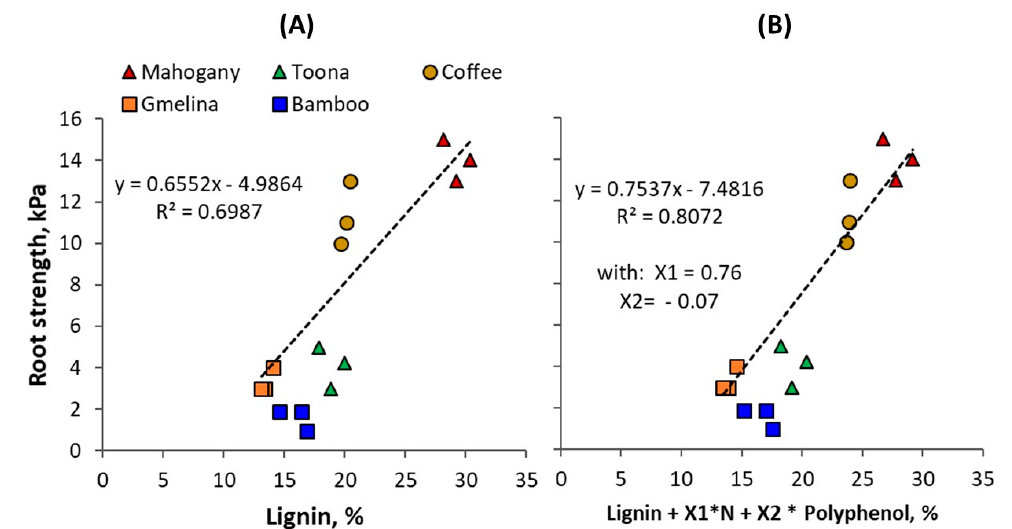
Figure 4. Regression of root tensile strength on ( A ) lignin content and ( B ) a linear combination of lignin content L, nitrogen content N, and polyphenol content P.